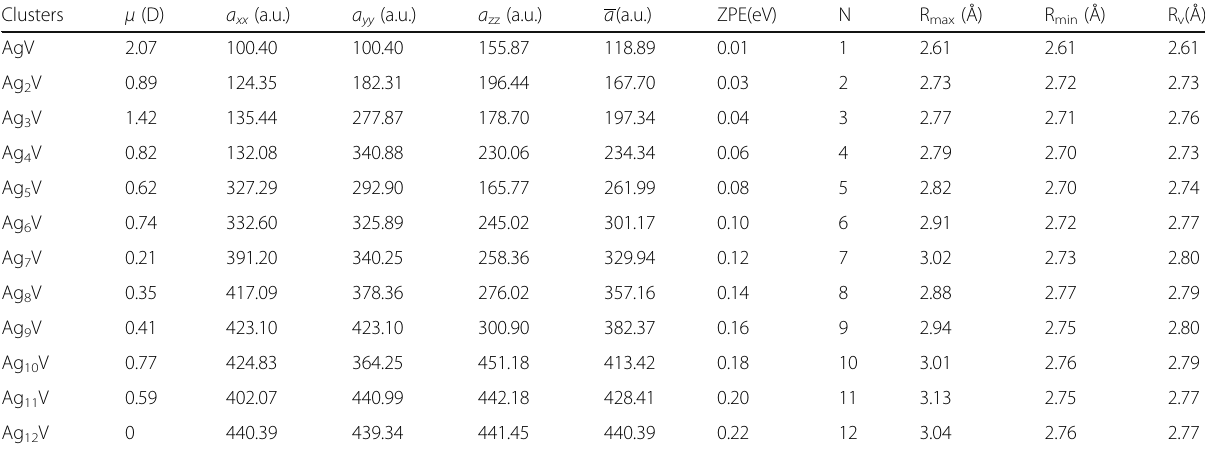
(cid:1) (cid:3) Table 2 The dipole moment ( μ ), polarizability a xx ; a yy ; a zz ; a , zero-point energy (ZPE) and maximum and minimum bond lengths (R max , R min ) of the most stable Ag n V ( n = 1 – 12) clusters and coordination number and average coordination bond length (R v